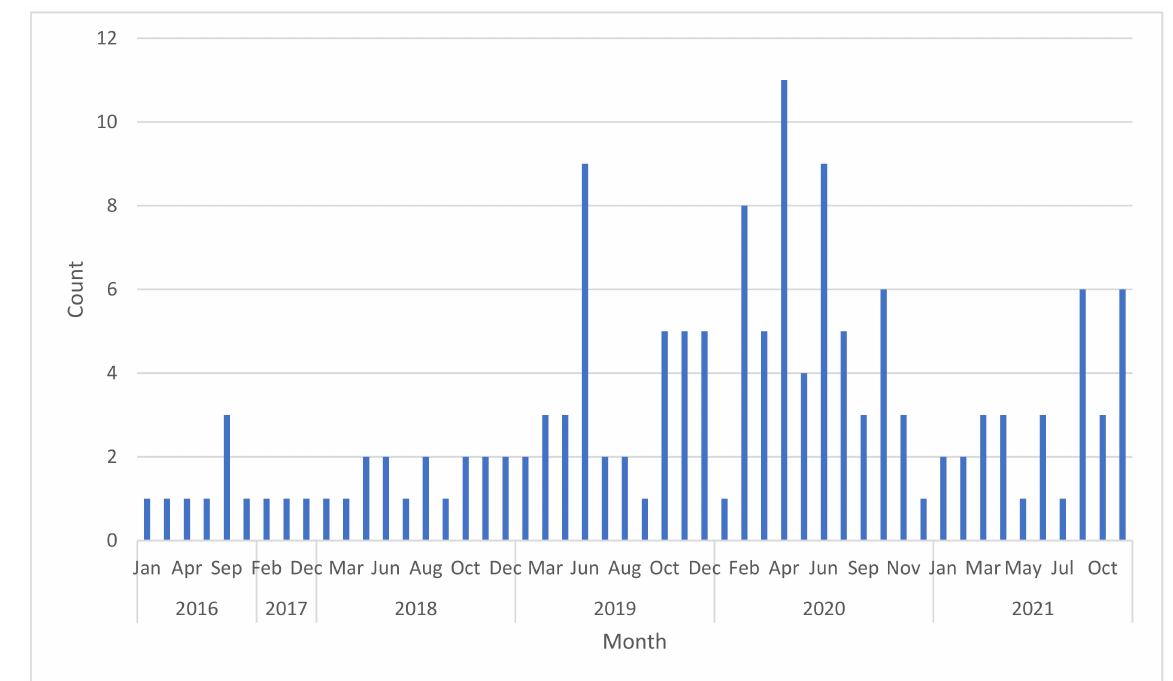
Figure 2. Air pollution publications per month from 2016–2021.